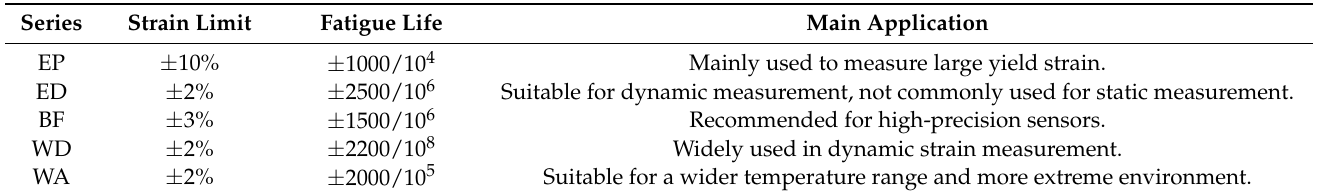
Table 1. Reference for selection of strain gauges.